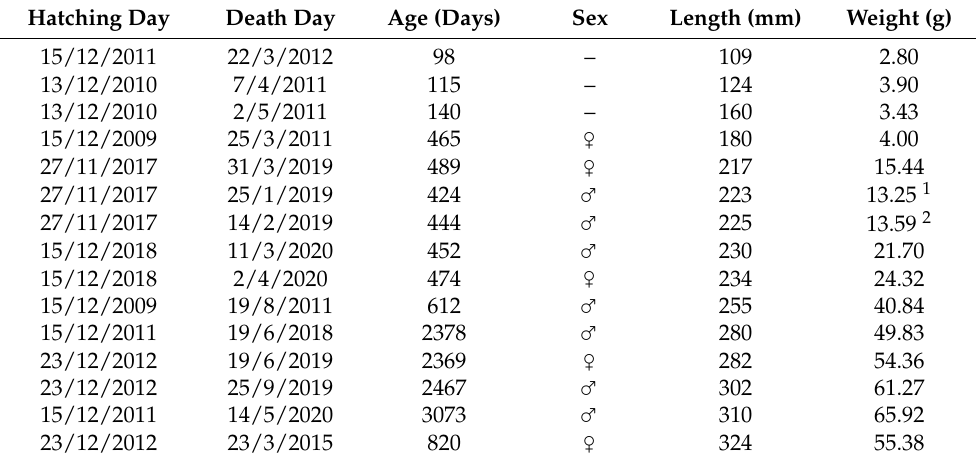
Table 2. Hatching and death dates (day/month/year), ages, ‘scalene’ lengths (see text) and weights of leafy seadragons ( Phycodurus eques ) kept at the Birch Aquarium at Scripps, La Jolla, CA. Hatching Day Death Day Age (Days) Sex Length (mm) Weight (g)